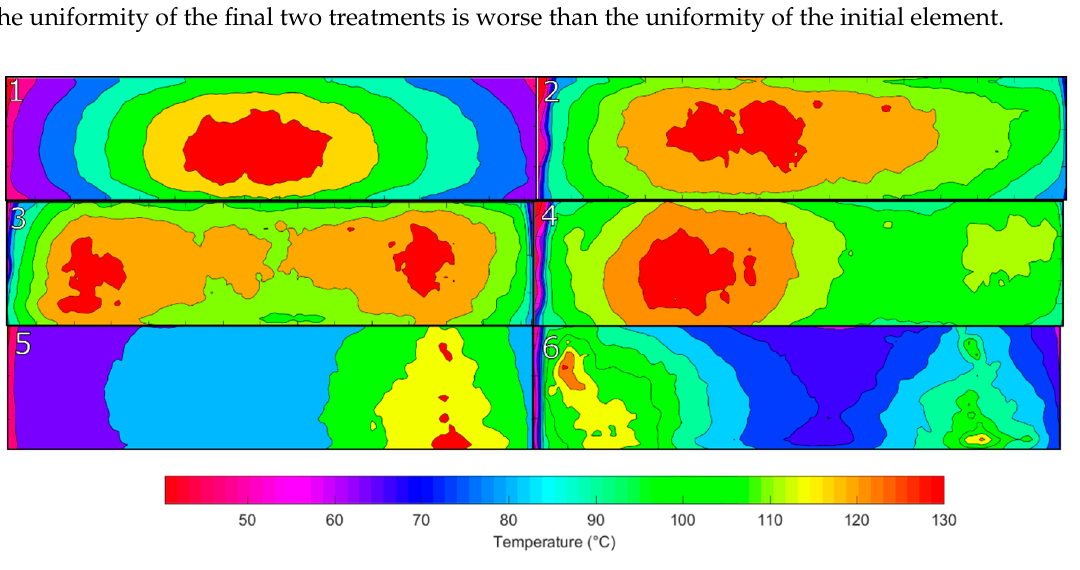
Figure 14. Contour plots of the surface temperature profile measurements shown after each cycle of ablation using the 20% method to treat element.